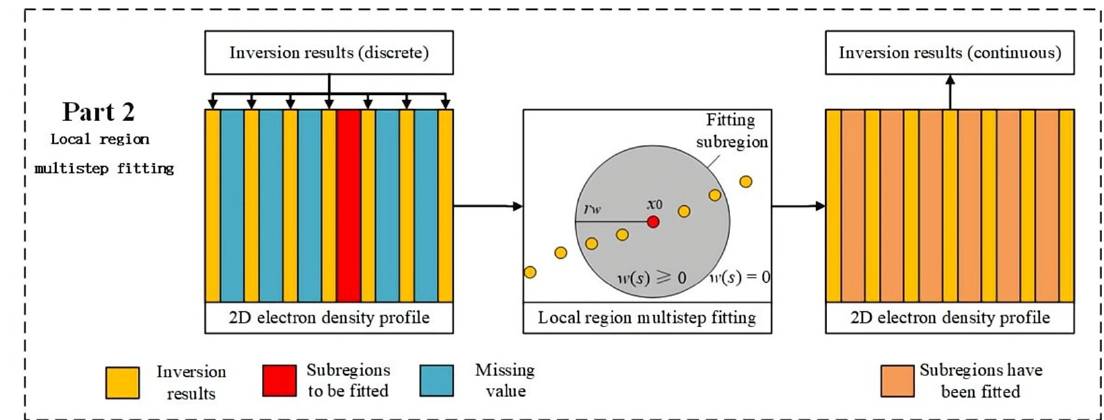
Figure 2. Local region multistep fitting algorithm.